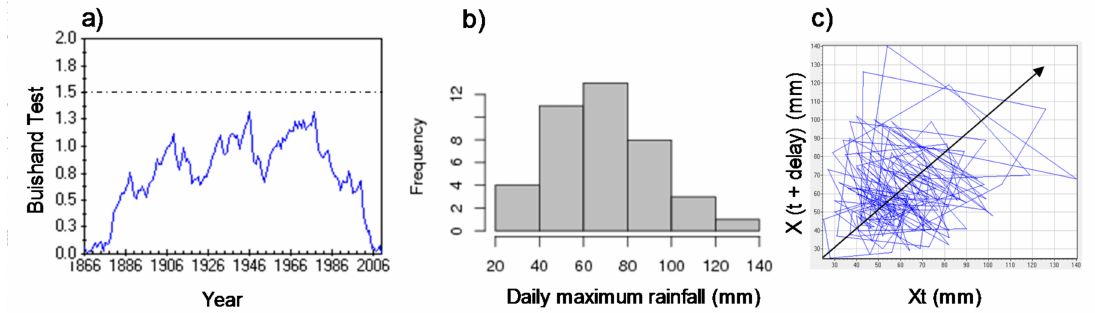
Figure 2. ( a ) Buishand statistic to determine years of departure from homogeneity; ( b ) Histogram of the frequency distribution with the bell-shaped curve of normal (Gaussian) distribution superimposed; ( c ) Attractor in the time-space